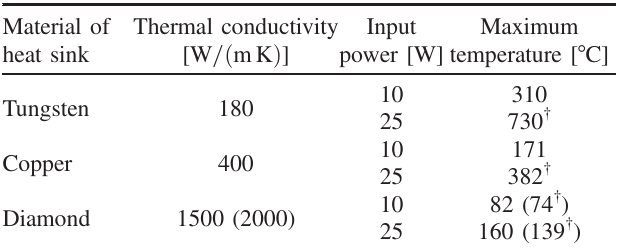
TABLE I. Maximum temperature attained owing to different heat sink materials (estimated). Values denoted with † are not indicated in Figs. 10 –